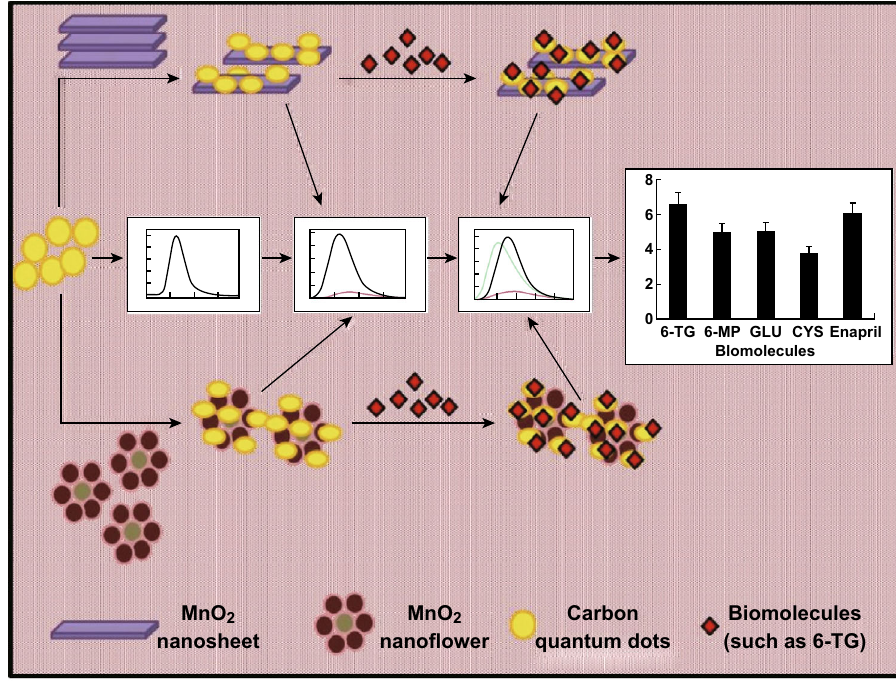
Fig. 21 Schematic illustration of the proposed CQD-based ‘‘off–on’’ sensor for 6-TG [258]. Copyright (cid:2) 2017 Elsevier